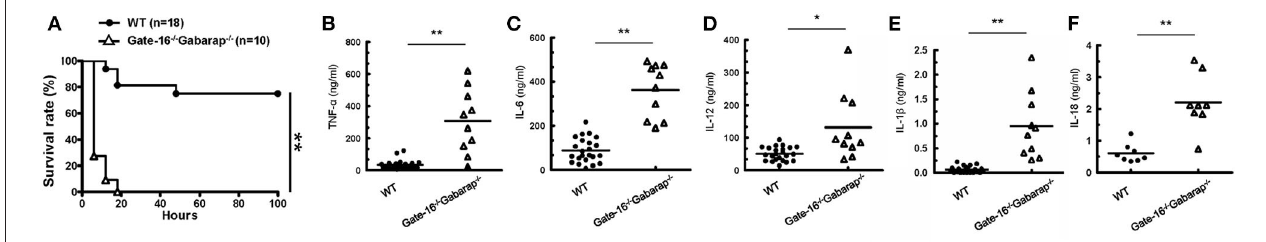
FIGURE 3 | High mortality in Gate-16 − / − Gabarap − / − mice during LPS-induced sepsis. (A) Wild-type (WT: n = 18), and Gate-16 − / − Gabarap − / − ( n = 10) mice were i.p. injected with 10 mg/kg body weight of poly(I:C) and then 7h later i.p. injected with LPS (0.1 mg/kg body weight). Morbidity and mortality were observed for 100h at 6h intervals. (B–F) Wild-type and Gate-16 − / − Gabarap − / − mice were i.p. injected with 10 mg/kg body weight of poly(I:C) and then 7h later i.p. injected with LPS (0.1 mg/kg body weight). Sera were taken 3h after LPS injection from WT ( n = 22) or Gate-16 − / − Gabarap − / − ( n = 10) mice for TNF- α (B) , IL-6 ( C ), IL-12 (D) , and IL-1 β (E) or from WT ( n = 8) or Gate-16 − / − Gabarap − / − ( n = 8) mice from IL-18 (F) serum concentrations were measured by ELISA. All data are combined data of three independent experiments. Log-rank test (A) and two-tailed Student t -test (B–F) * P < 0.05 and ** P <